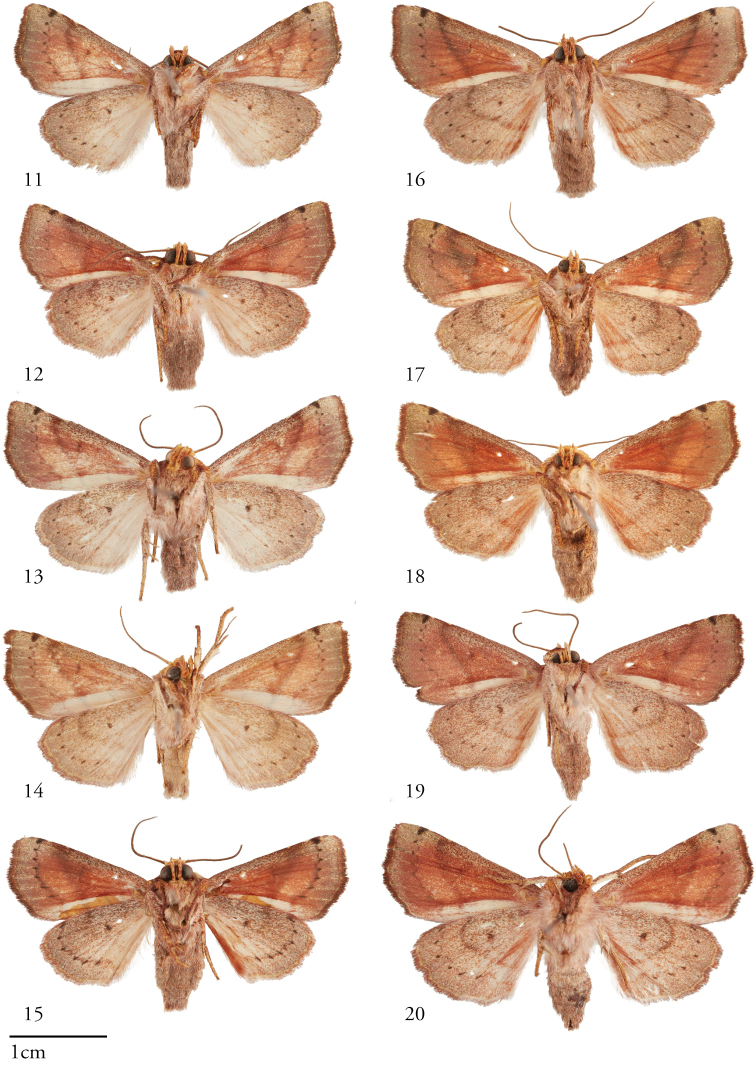
Ventral habitus of Apricapatula, males (left, 11–15) and females (right, 16–20). 11USNMENT01463599 05-SRNP-48763 12USNMENT01463665 05-SRNP-2726 13USNMENT0146389414USNMENT0146389315USNMENT01463658 14-SRNP-80751 16USNMENT01463798 10-SRNP-44267 17USNMENT01463999 11-SRNP-42773 18USNMENT01463895 07-SRNP-46182 19USNMENT01463671 08-SRNP-104889 20USNMENT01463571.